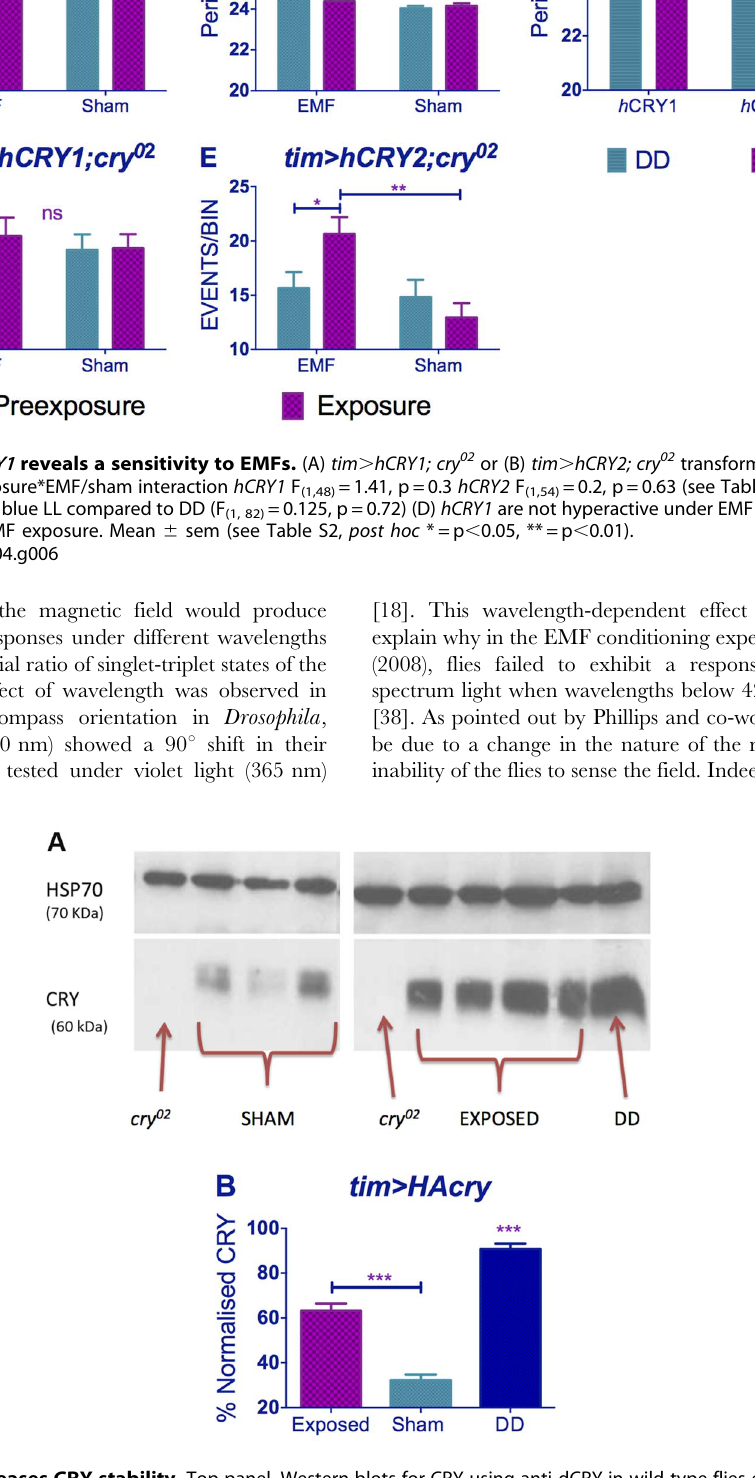
Figure 7. EMF exposure increases CRY stability. Top panel. Western blots for CRY using anti-dCRY in wild-type flies expose to EMF or sham in dim blue LL with cry 02 and DD control. HSP is used as loading control. Bottom panel. Quantification based on 3 biological replicates each with 3 technical replicates (repeated measures ANOVA F (2,6) =113.1, p , 0.001, post hoc *** p , 0.001). Mean 6 sem.